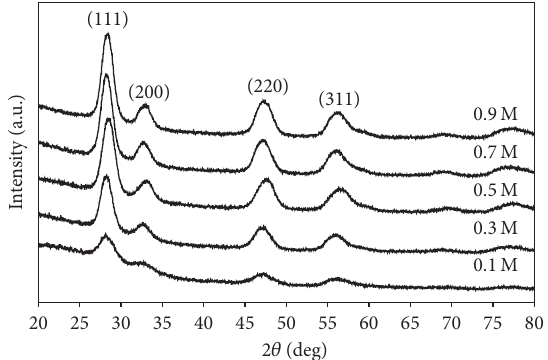
F 2: GAXRD patterns of CeO